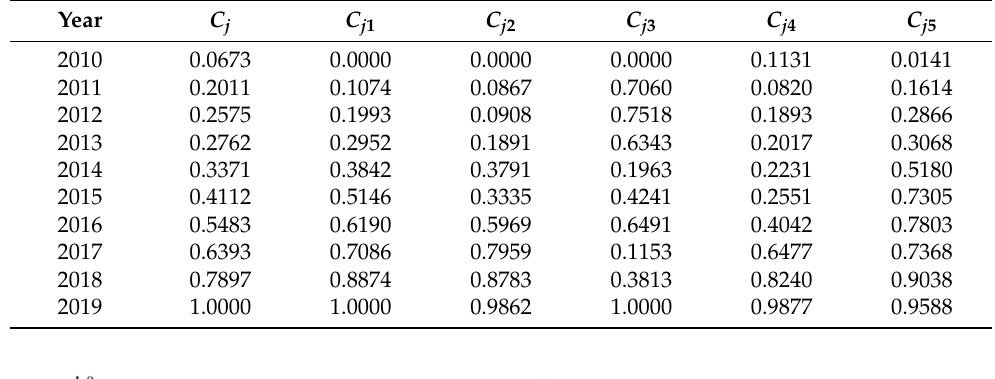
Table 2. The overall and sub-dimensional evaluation results of the water environment governance performance in the Taihu basin.